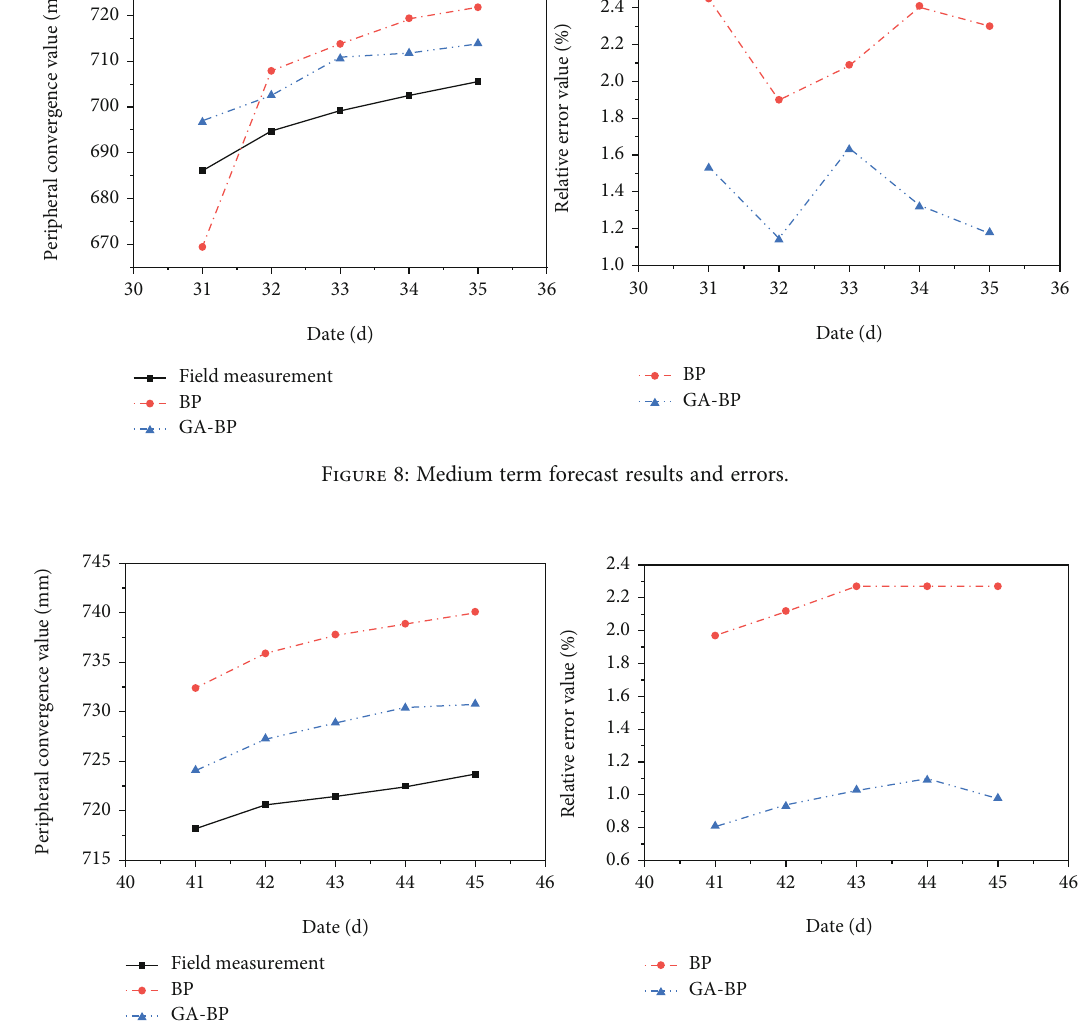
Figure 9: Later prediction results and